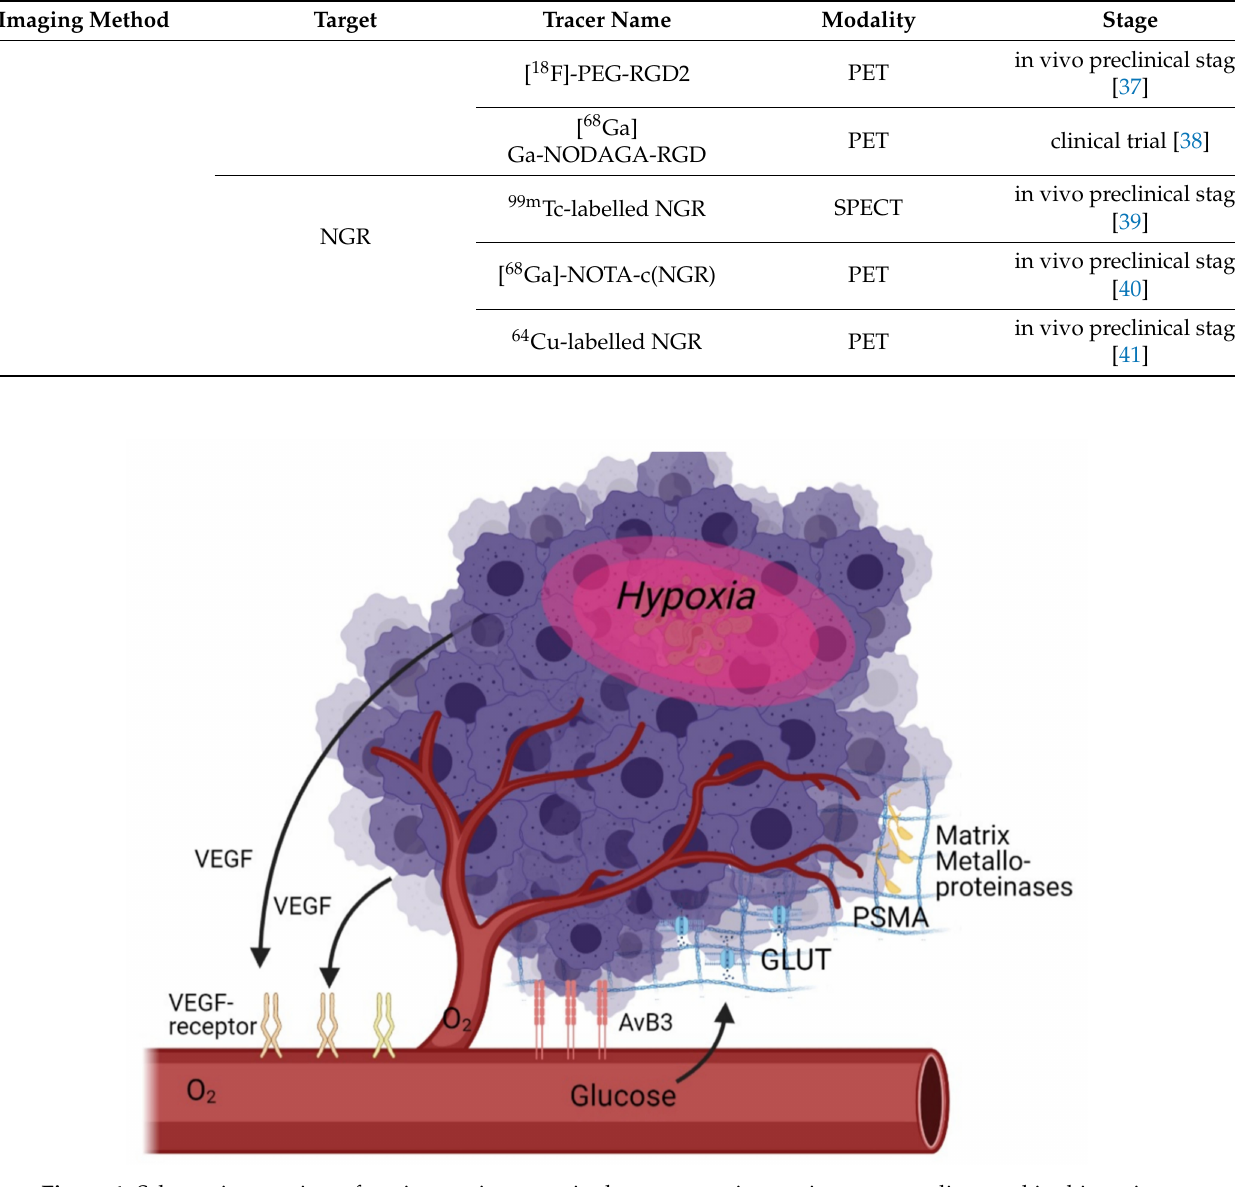
Figure 1. Schematic overview of angiogenesis targets in the tumour microenvironment as discussed in this